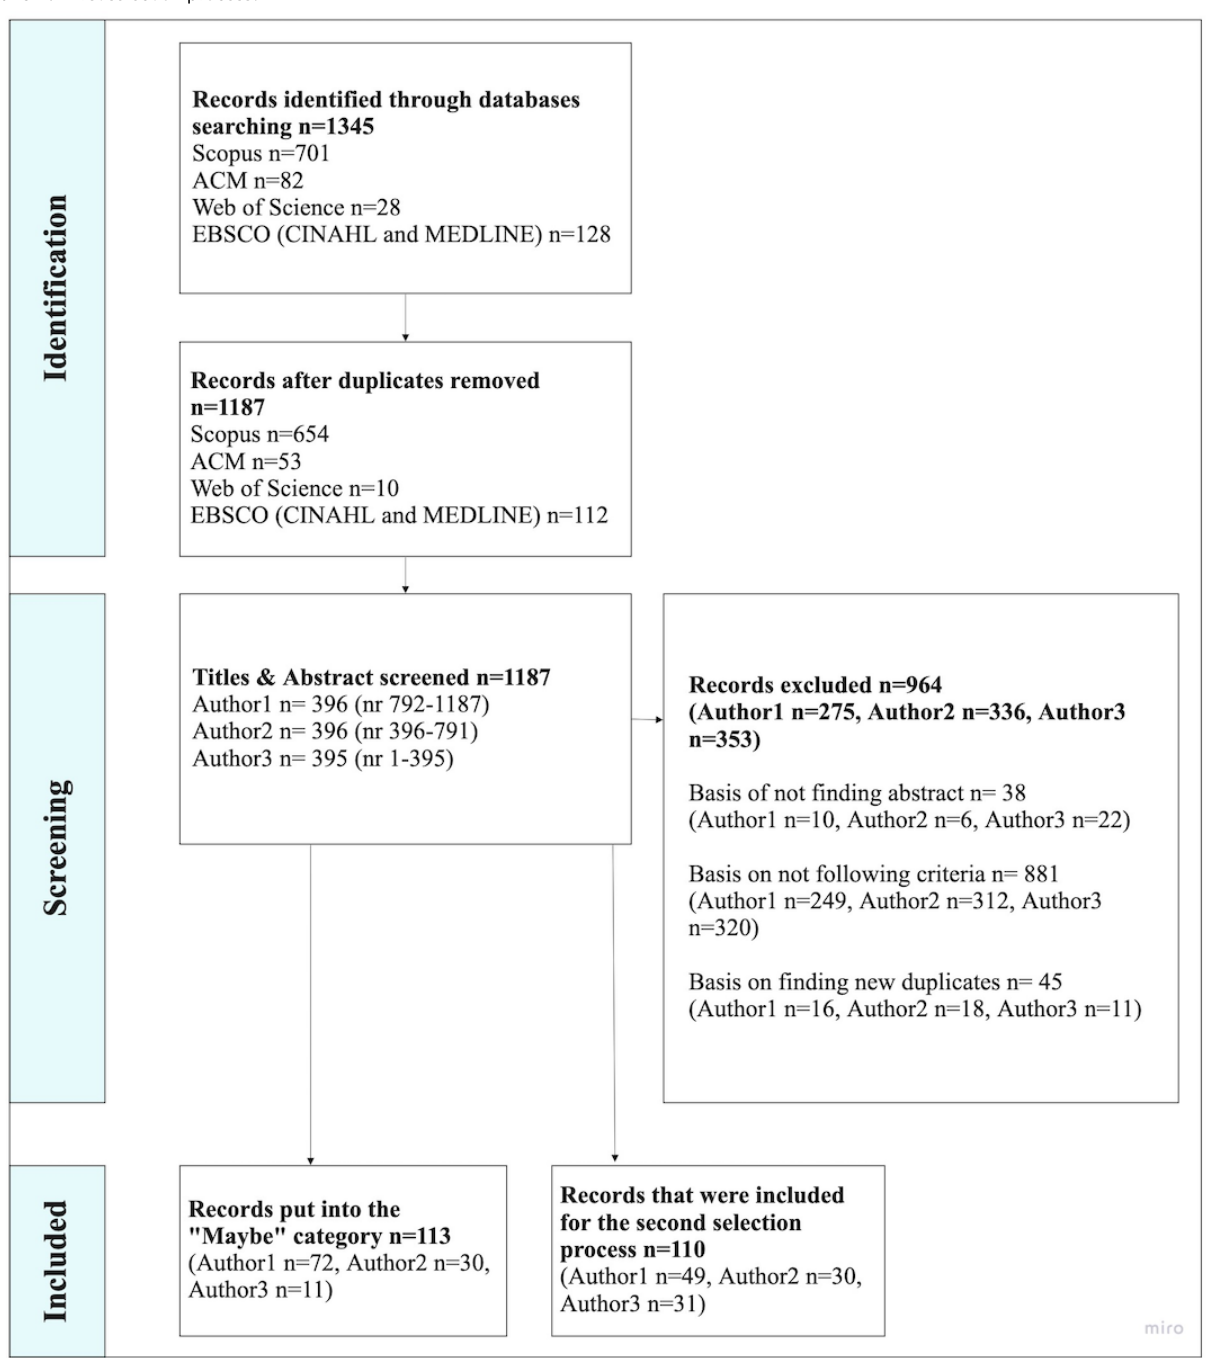
Figure 2. First selection